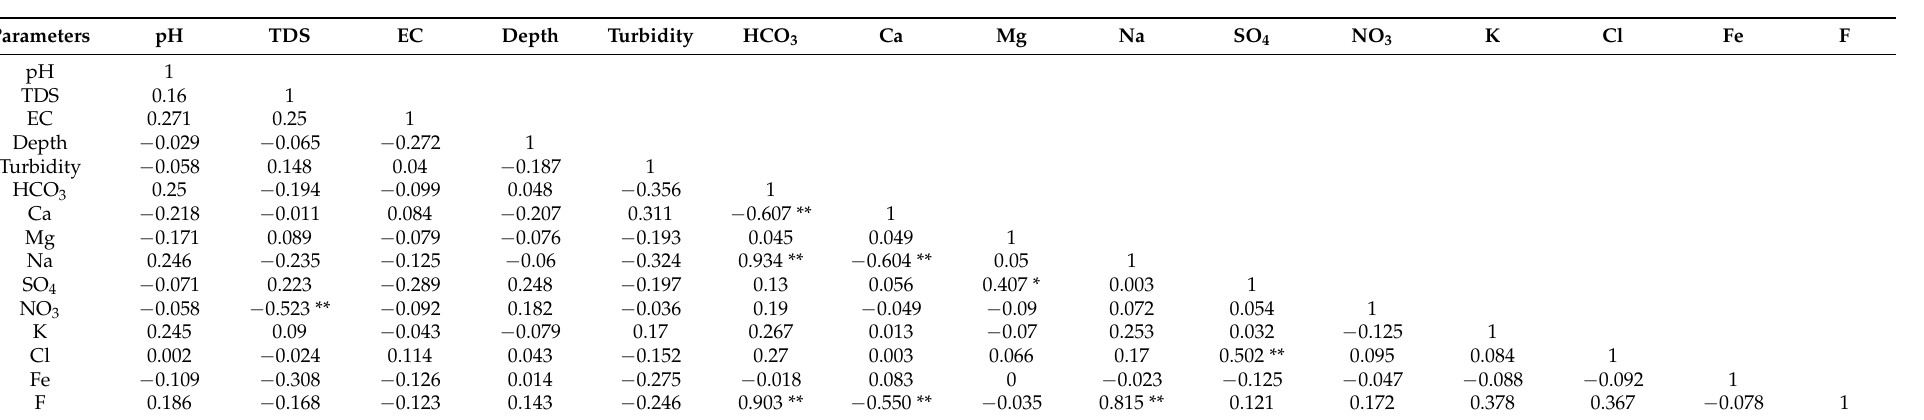
Table 3. Pearson’s correlation analysis of selected